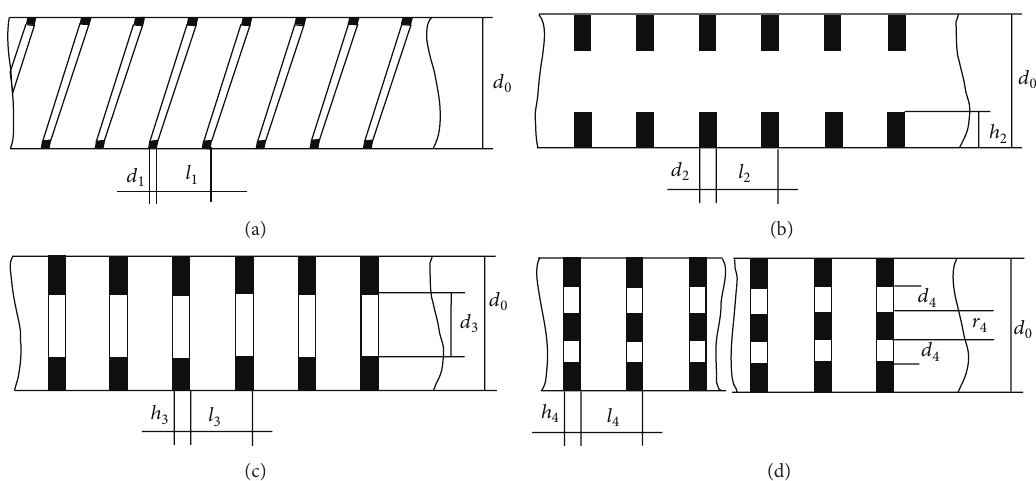
Figure 23: Typical schema of use of passive elements for acceleration of “plane” flames: helixes (Tshelkin spiral), each helix is characterized by three parameters with the dimensions of length: tube diameter 𝑑 0 , thickness 𝑑 1 , and pitch 𝑙 1 of spiral (a); singly standing rods (“forest” schema) (b) (in addition to the dimensions of an individual rod such as diameter 𝑑 2 and length ℎ 2 , the rod-type accelerator is characterized by the number 𝑛 of the used rods and a law of their distribution in the tube, for example, by the step along the axis, azimuthal displacement in neighboring planes, etc.); disks with holes coaxial (c) (the characteristic dimensions are thickness ℎ 3 and displacement 𝑙 3 of disk, and hole diameter 𝑑 3 ; the number of holes is of importance also), or with displacement (the dimensions are thickness ℎ 4 and displacement 𝑙 4 of disk, hole diameter 𝑑 4 and distance 𝑟 4 among holes)